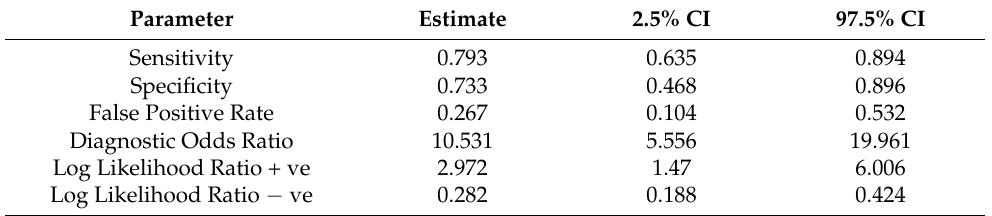
Table 2. The pooled performance of the current systematic review.